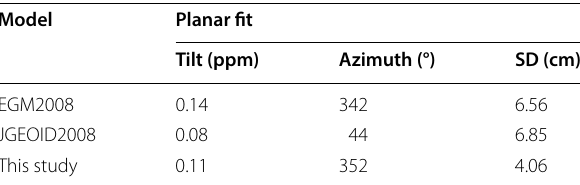
Table 3 Planar fitting of gravimetric geoid models to GNSS/ leveling geoid heights at 971 benchmarks for EGM2008, JGEOID2008, and this study